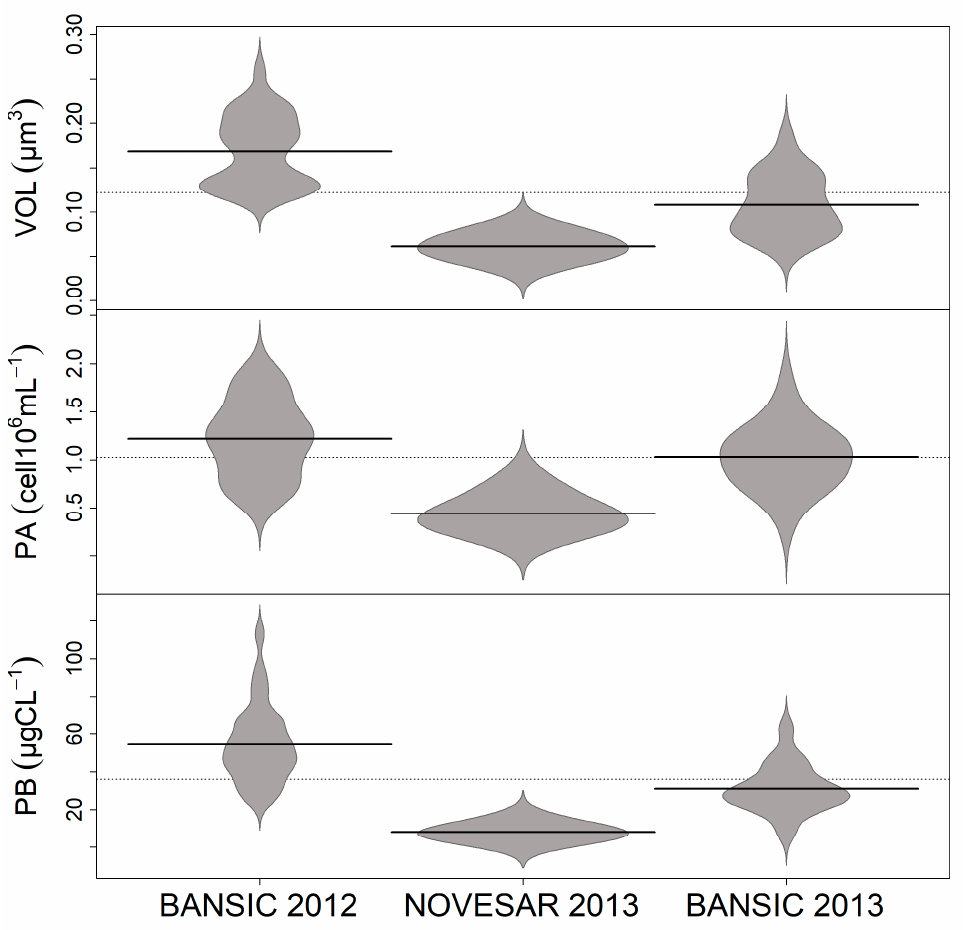
Figure 2. Beanplots of the entire dataset of the volumes (VOL), abundance (PA) and biomass (PB) of prokaryotic cells distributed in BANSIC 2012, NOVESAR 2013 and BANSIC 2013. Dashed lines represented overall mean values, black lines mean values within each period and grey areas show the empirical distribution of each parameter.